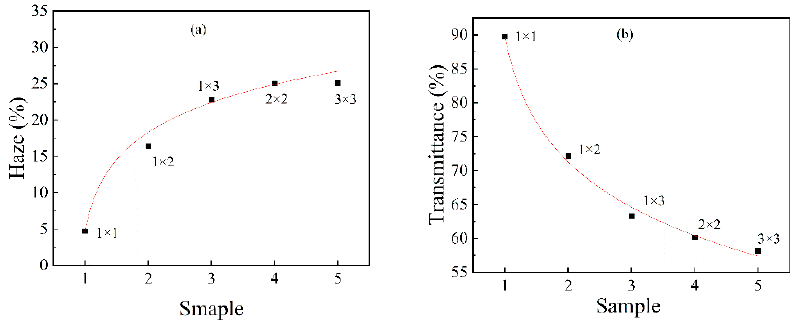
Figure 8. The haze and transmittance of PA510/SiO 2 films: ( a ) haze and ( b ) transmittance.